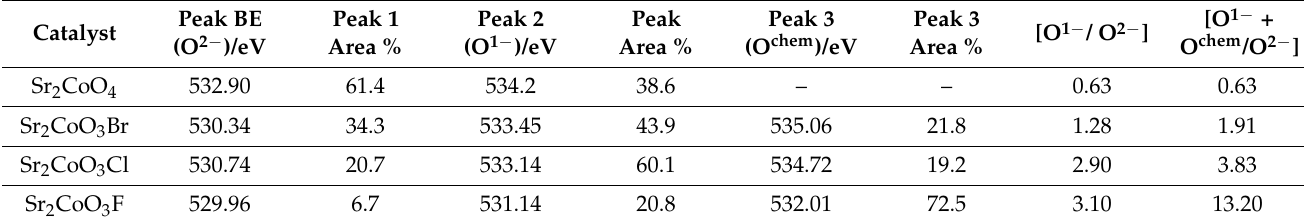
Table 2. Analysis values of the deconvoluted O 1s peaks of the oxyhalide catalysts. Peak Catalyst